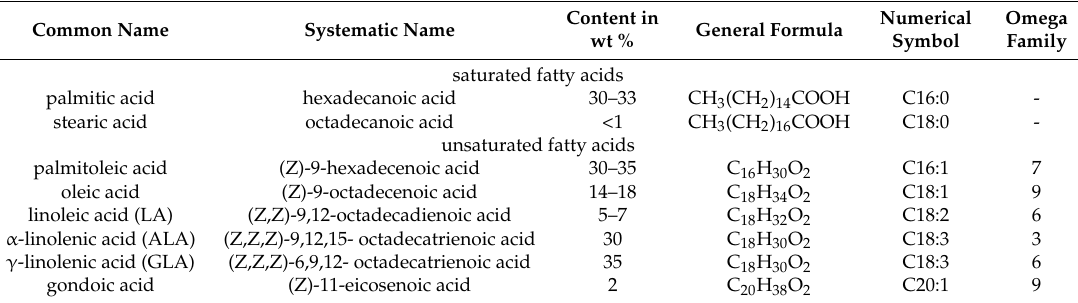
Table 1. Composition of fatty acids in sea buckthorn (SB)